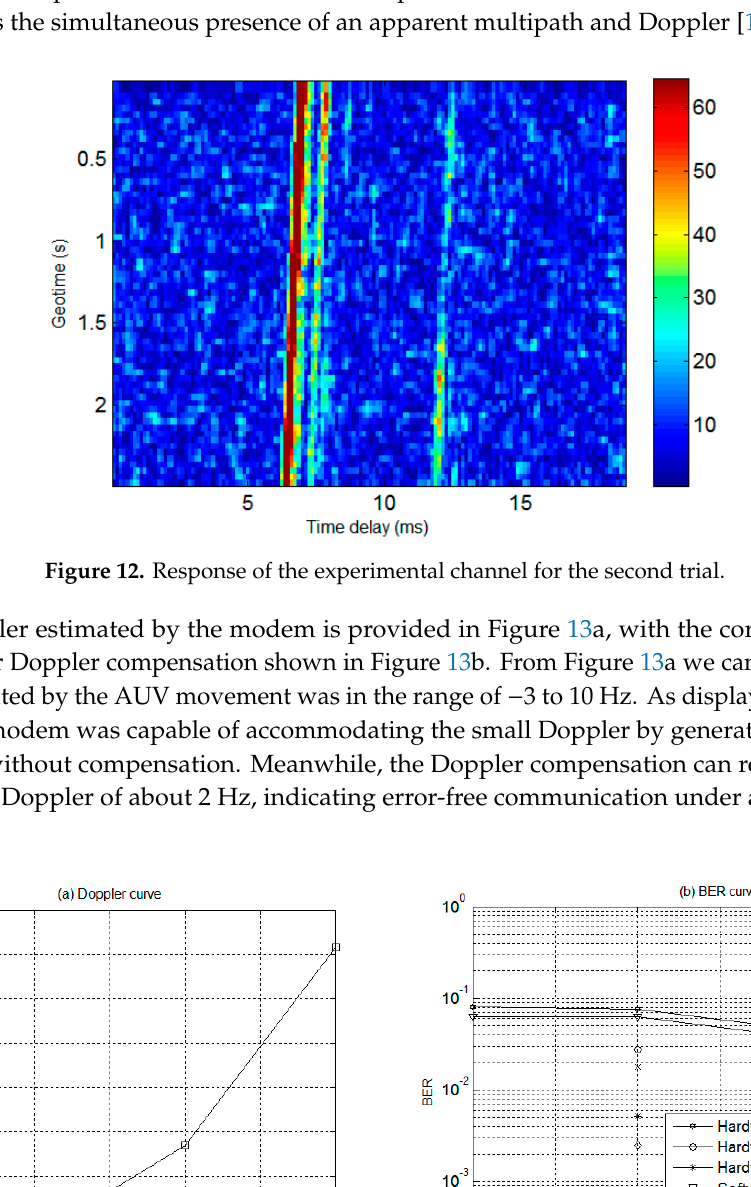
Figure 13. Doppler and bit error rate curves obtained by the modem onboard AUV. ( a ) Doppler curve, ( b ) BER curve.